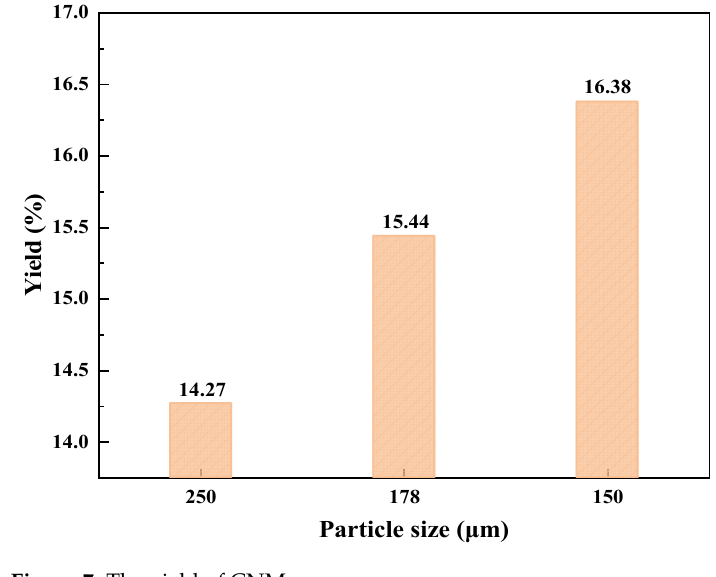
Figure 7. The yield of CNMs.